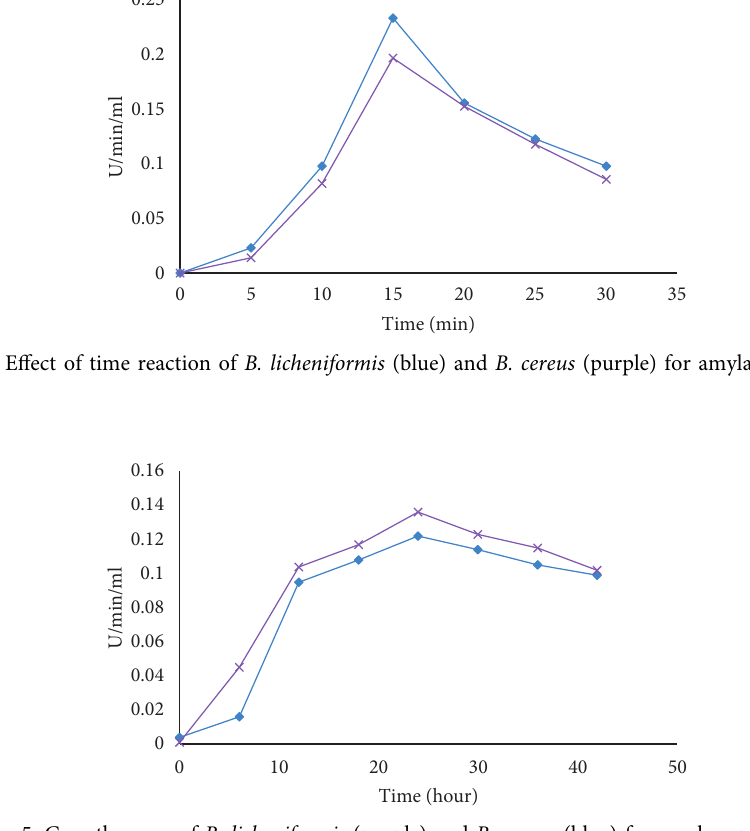
Figure 5: Growth curve of B. licheniformis (purple) and B. cereus (blue) for amylase production.